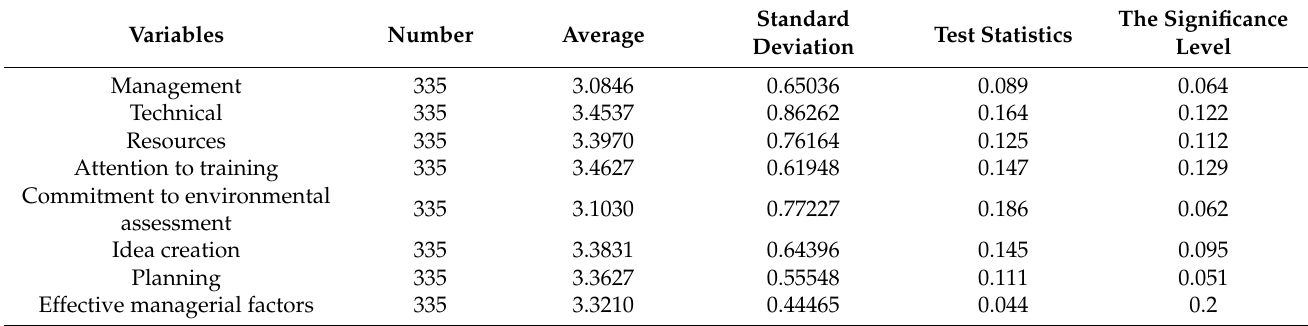
Table 34. The result of the Kolmogorov–Smirnov test of research